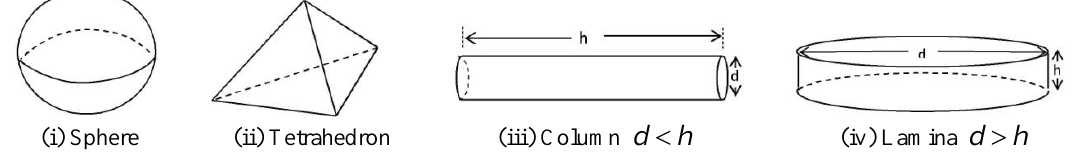
Figure 2. Shapes of nano solid copper particles